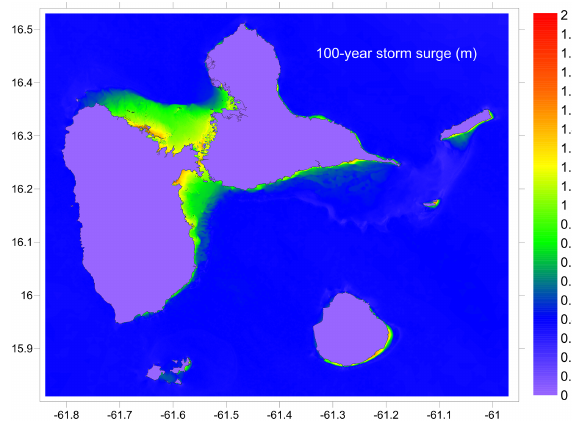
Figure 7. 100-year surge levels in Guadeloupe (in